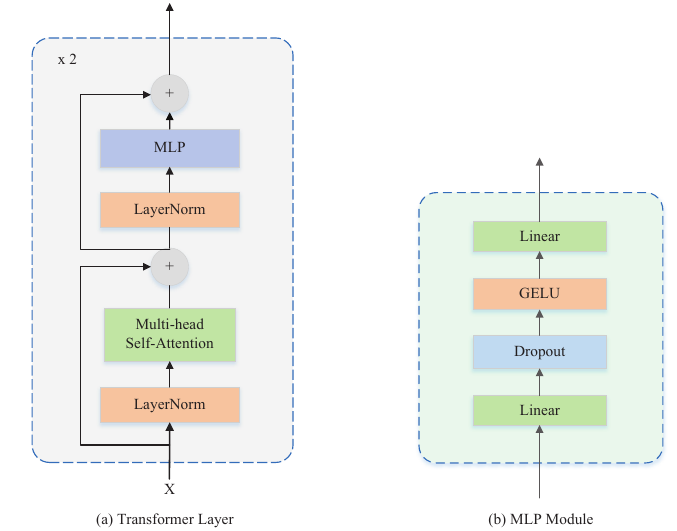
Figure 3. Transformer layer and MLP